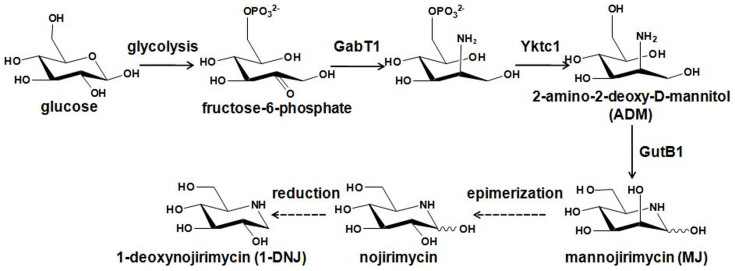
The proposed biosynthetic pathway of 1-DNJ, adapted from Horenstein23.